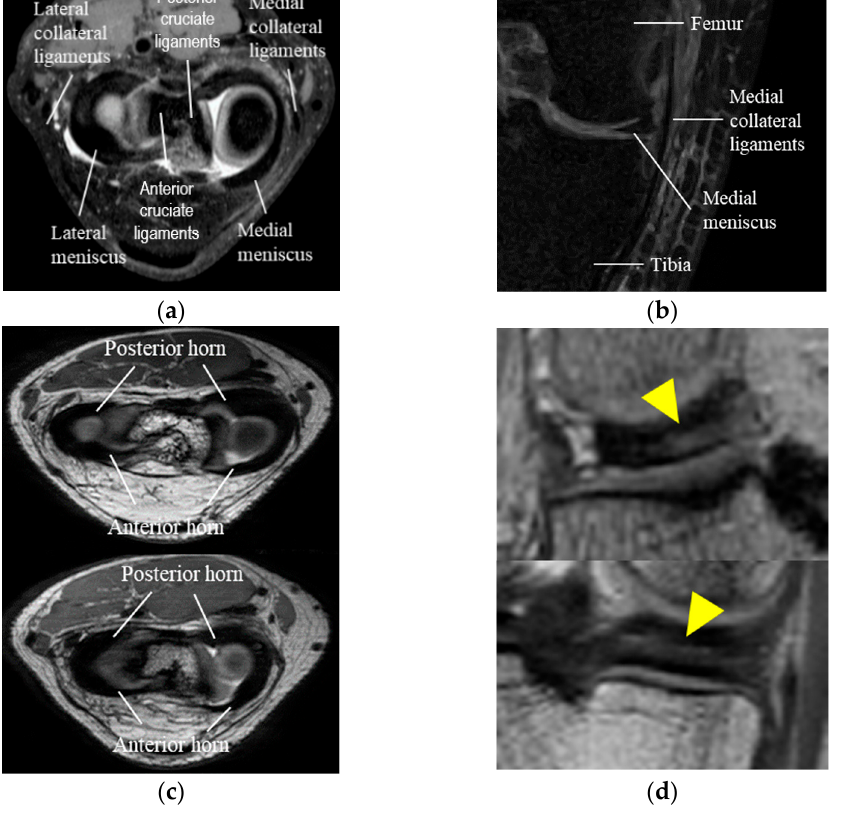
Figure 1. Characteristics of the meniscus in knee MR images: ( a ) Structures of the lateral and medial meniscus in the axial view; ( b ) Similar intensity of the medial meniscus and collateral ligaments in the coronal view; ( c ) Shape variances of anterior and posterior horns of the meniscus among patients; ( d ) Inhomogeneous intensity of lateral and medial meniscus (yellow arrow) in knee MR images.